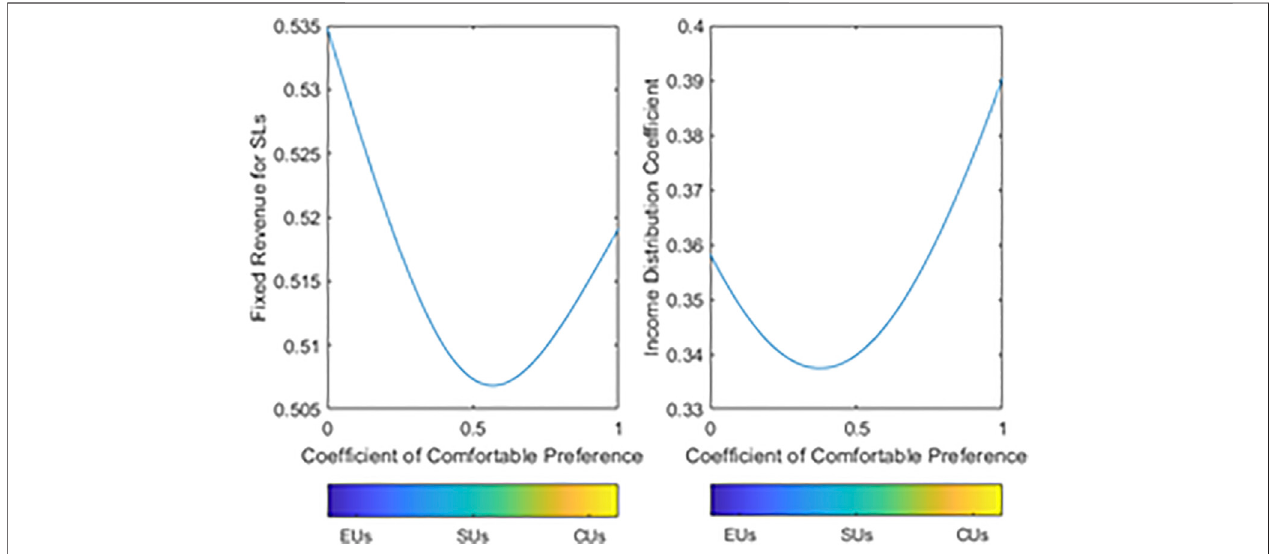
FIGURE 3 | Relationship between SLs ’ fi xed income/income distribution coef fi cient and preference in the case of asymmetric information.